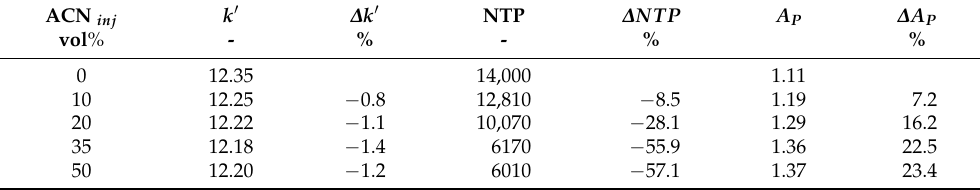
Table 1. Role of the injection solvent. Dependency of k (cid:48) , NTP , and peak asymmetry, A P , on the amount of acetonitrile in the injection solvent, ACN inj , for the example of homolog n = 20. Deviations in % from the corresponding value for 100% water as injection solvent. Conditions: Analytical column, eluent 20 vol% ACN, 50 ◦ C, 0.7 mL/min, samples: 10 µ L of 0.2 g/L PEG 1000. ACN inj k (cid:48) ∆ k (cid:48)